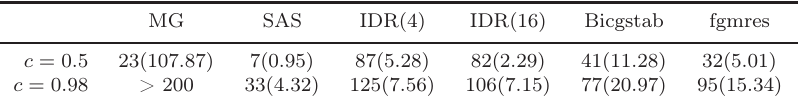
Table 1. Iterations number and CPU time in s (in bracket) at σ = 100